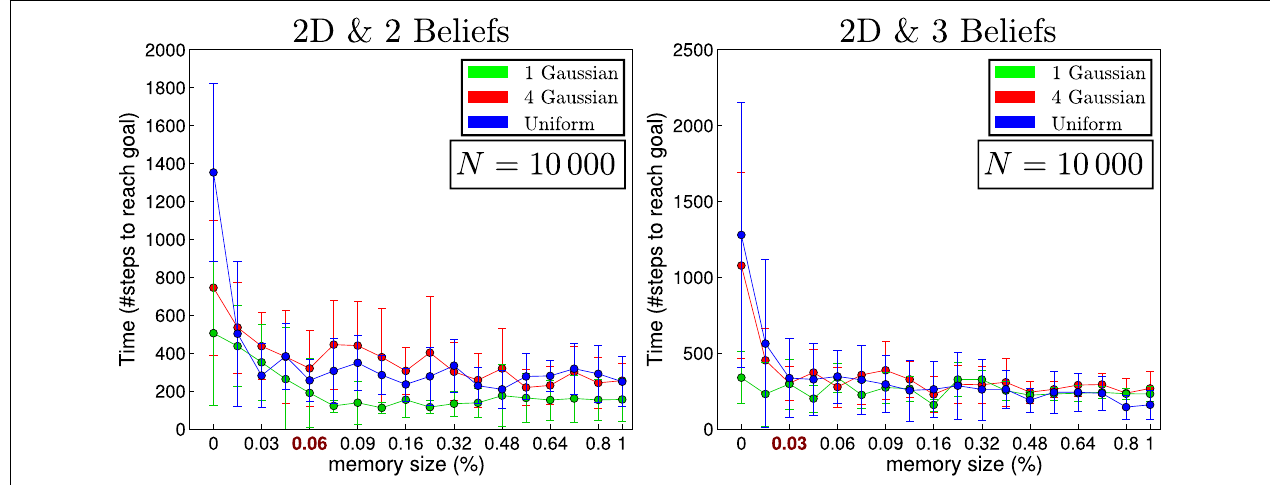
FIGURE 15 | Memory size vs time to find objects in 2D. The initial beliefs correspond to those of Figure 13A for Gaussian (green line), Figure 13B for 4 Gaussians (red line), and Figure 13C for uniform (blue line), both objects are initialized according to Figures 13D,E